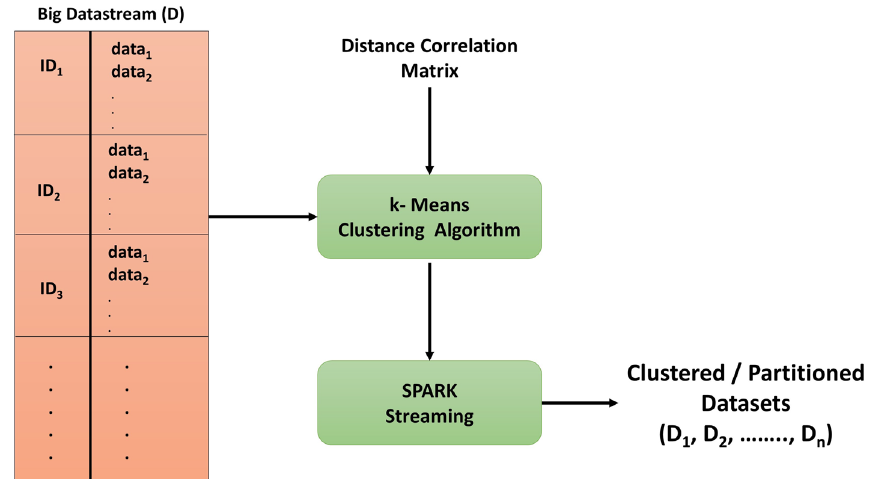
Fig. 4 Step 2 of proposed methodology